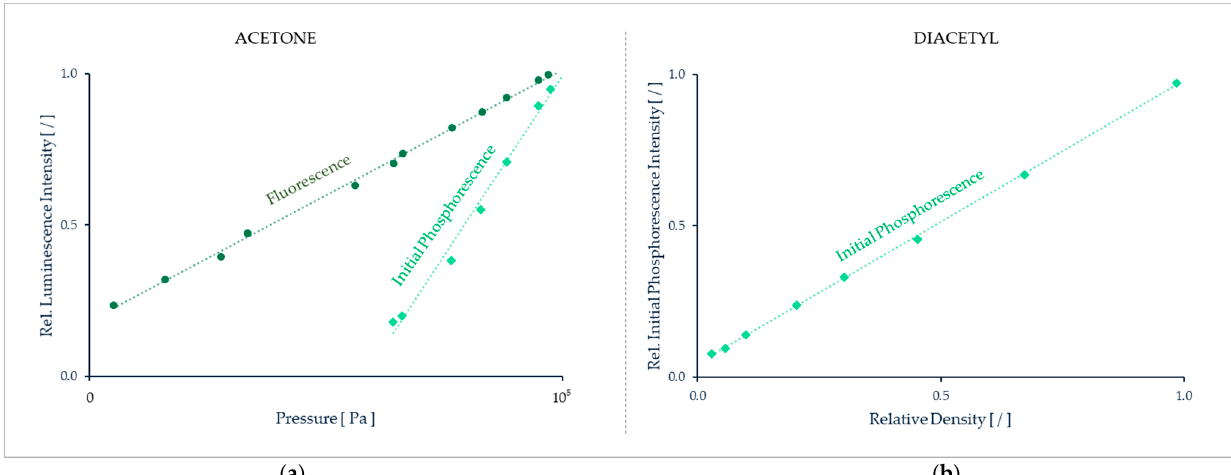
Figure 37. ( a ) ( ◆ ) Pressure dependence of acetone phosphorescence emission intensity collected for 100 ns < t < 600 ns, normalized by its value at atmospheric pressure for T = 294 K and a molar fraction of acetone of 10.4%; ( ● ) experimental fluorescence intensity collected for 0 < t < 10 ns normalized by its value at atmospheric pressure. Data from Si Hadj Mohand et al. [184]. ( b ) Density dependence of initial phosphorescence intensity of diacetyl: the ordinate is normalized by the largest initial phosphorescence intensity of each experimental run, and the abscissa is normalized by the highest density of each experimental run. Data from Jian-Bang et al. [182].